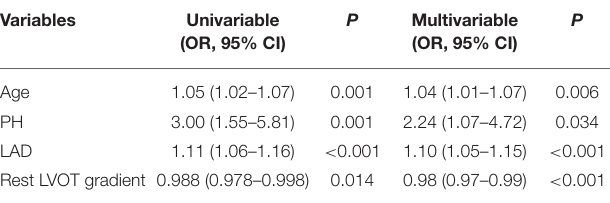
TABLE 3 | Logistic regression models for analysis of the risk factors of AF.